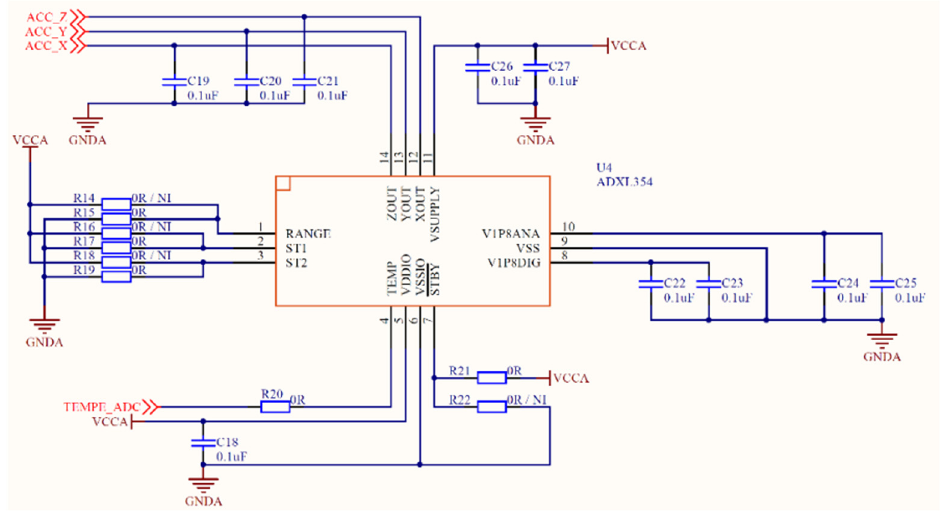
Figure 2. The circuit diagram of ADXL354.